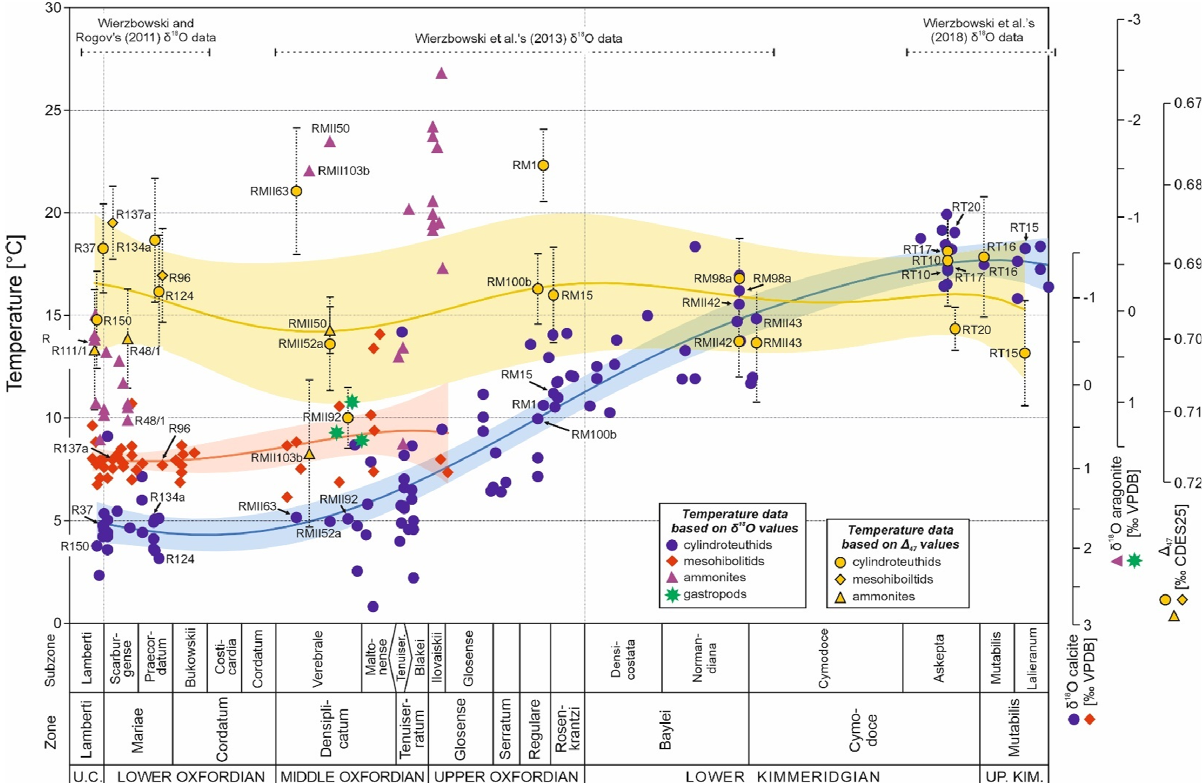
Figure 15. Isotope data and palaeotemperatures calculated from δ 18 O and Δ 47 (CDES 25) values of well-preserved calcareous fossils from the uppermost Callovian–lowermost Upper Kimmeridgian (Middle–Upper Jurassic) of the Russian Platform (after Wierzbowski et al. [253]). The oxygen isotope temperatures are calculated using the equations of Friedman and O’Neil [150] and Böhm et al. [158] for calcite and aragonite fossils, respectively, assuming δ 18 O water value of − 1‰ VSMOW. The clumped isotope temperatures are calculated using the equation of Wacker et al. [361]. Temperature data points derived from δ 18 O and Δ 47 (CDES 25) values of the same samples are marked with sample numbers. Smoothed curves and corre- sponding 95% confidence intervals (blue, red, and yellow areas) are generated using a locally weighted second order polynomial regression with a bandwidth of 5 stratigraphical units, i.e., ca. 0.3 Myr. The δ 18 O data were compiled from Wierzbowski and Rogov [388], Wierzbowski et al. [55] and Wierzbowski et al. [253]—see marked data ranges.